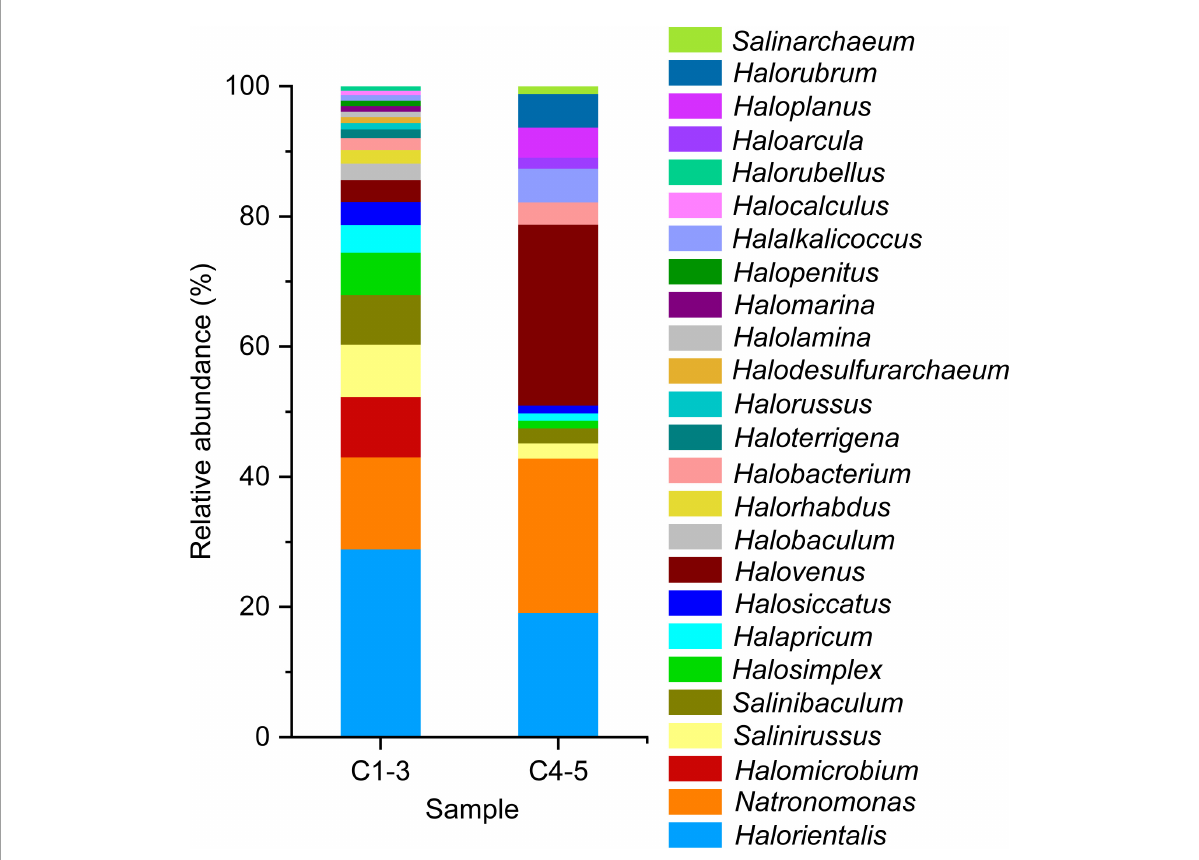
FIGURE5 Haloarchaeal composition in brine samples revealed by clone library at the genus level under culture-independent approach. Almost complete length of the 16S rRNA gene was obtained by using F8 and R1462 primer pair. C1-3, three brine samples collected in July 2021; C4-5, two brine samples collected in August